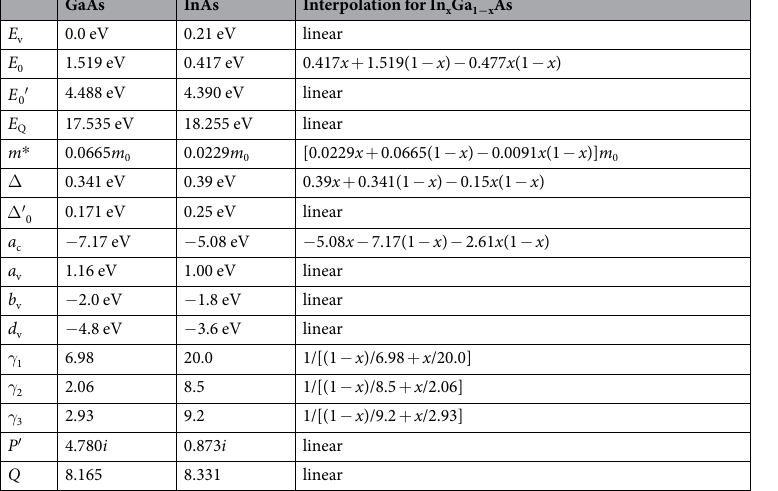
Table 1. Material parameters used in the calculations 3,46